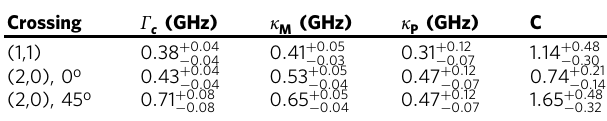
Table 1 Coupling, loss rates and cooperativities for the different crossings